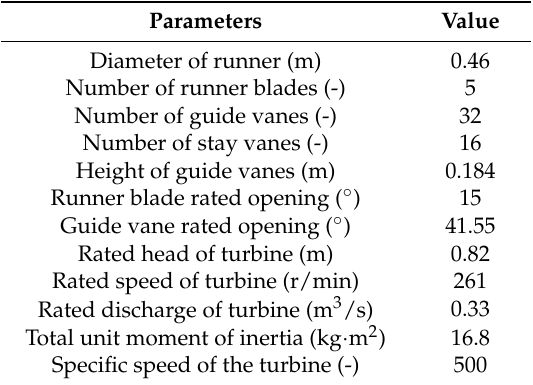
Table 1. Main parameters of the Kaplan turbine model.